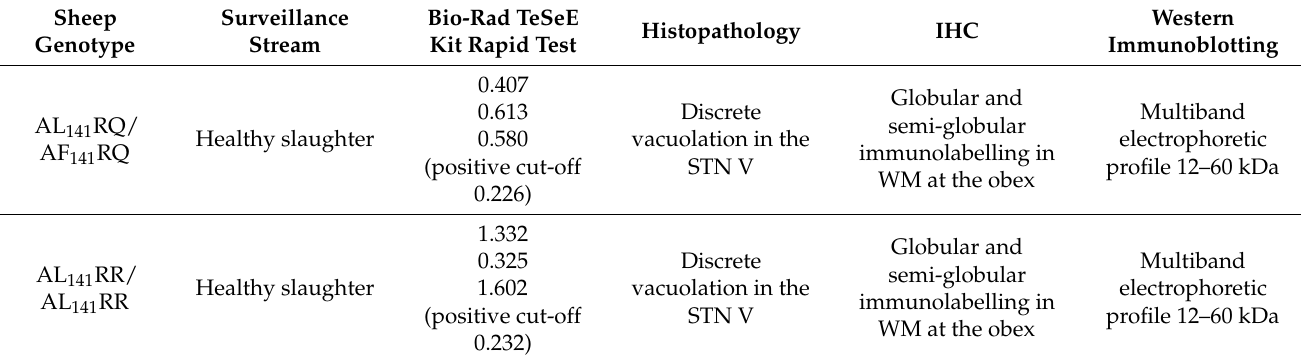
Table 1. Atypical Scrapie cases selected for strain typing by mouse bioassay showing results of diagnostic observations and